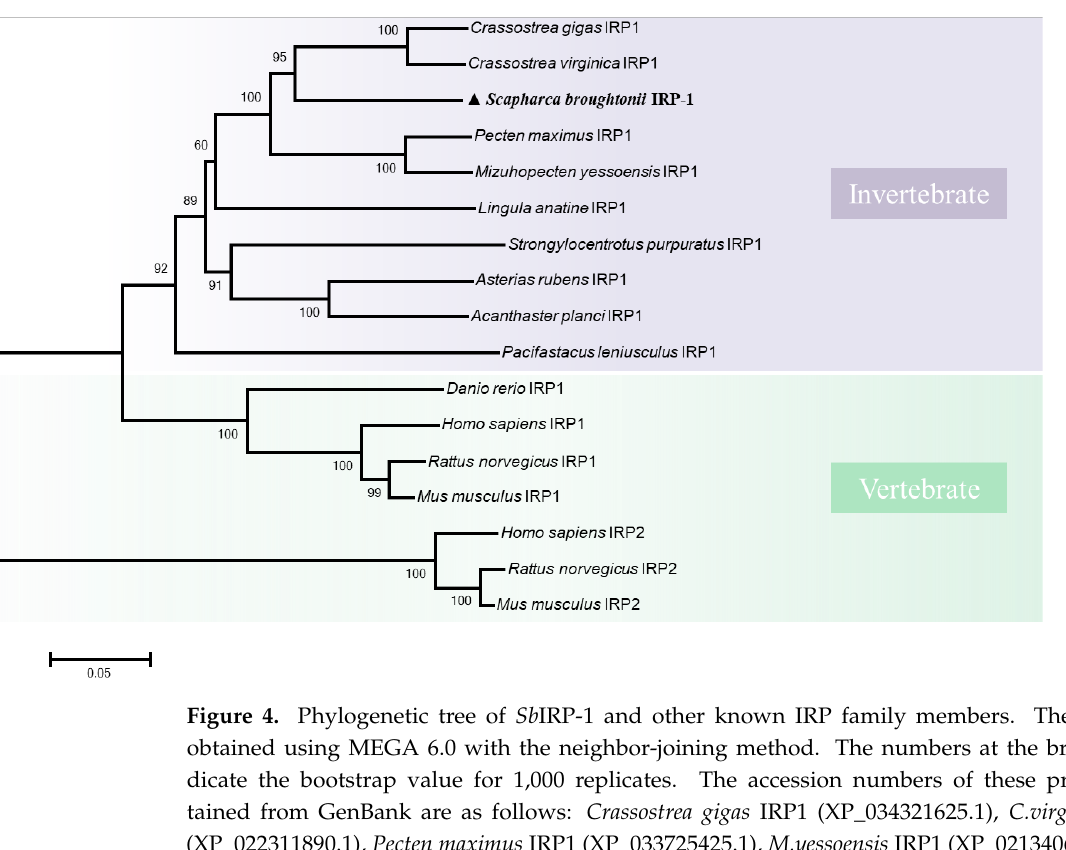
Figure 3. The three-dimensional structures of Sb IRP-1. The structures were predicted by using SWISS-MODEL and displayed by PyMol. The α -helix structure is marked in cyan, the β -sheet struc- ture in red, and the L-ring in magenta. Sb IRP-1 model 1: assembling with the [4Fe-4S] cluster; model 2: disassembling with the [4Fe-4S] cluster.